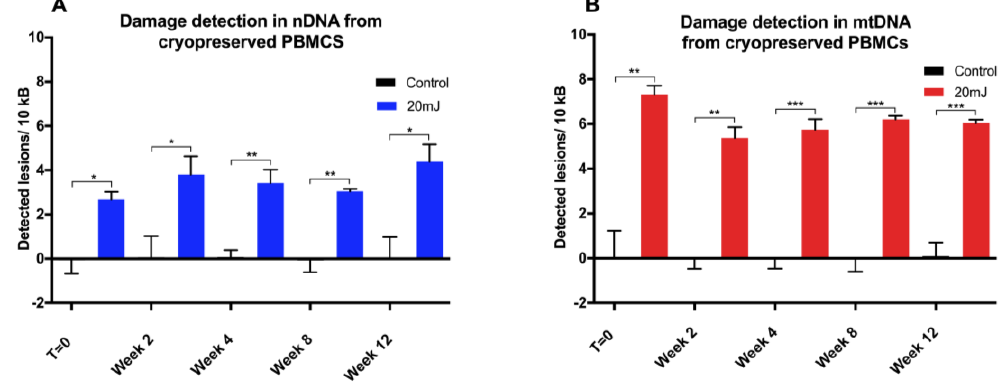
Figure 3. DNA damage assessment in cryopreserved PBMCs. qPCR measurement of UVC-induced ( A ) nDNA and( B ) mtDNA damage in revived PBMCs following cryopreservation over 12 weeks ( n = 3). Results are presented as mean ± SE. * p < 0.05, ** p < 0.01, *** p < 0.001.